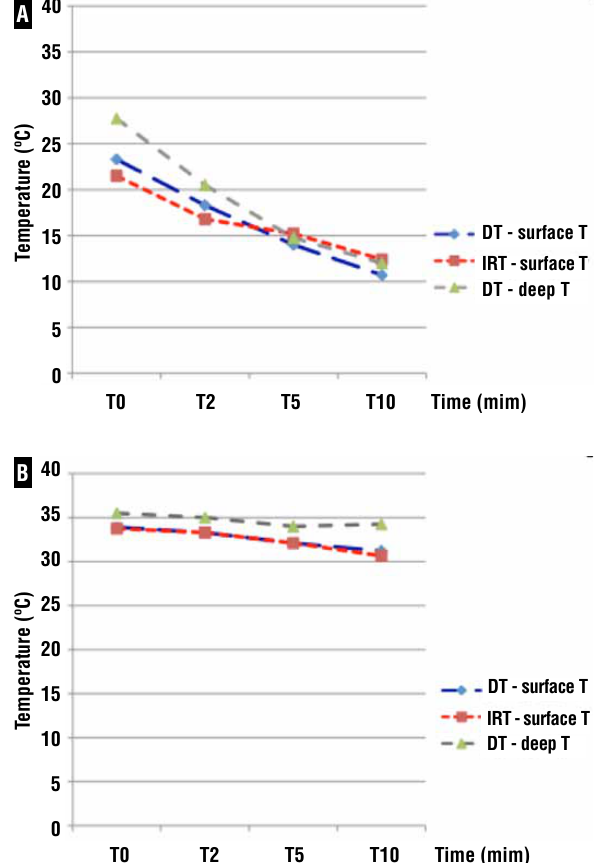
warm (B) renal ischemia measured by digital and infrared